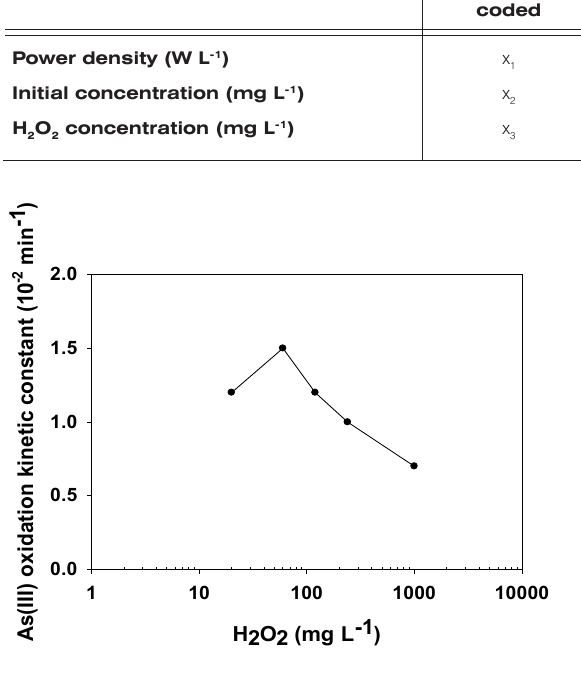
Table 1. Minimum and maximum levels of three factors in terms of coded and uncoded symbols. Variable